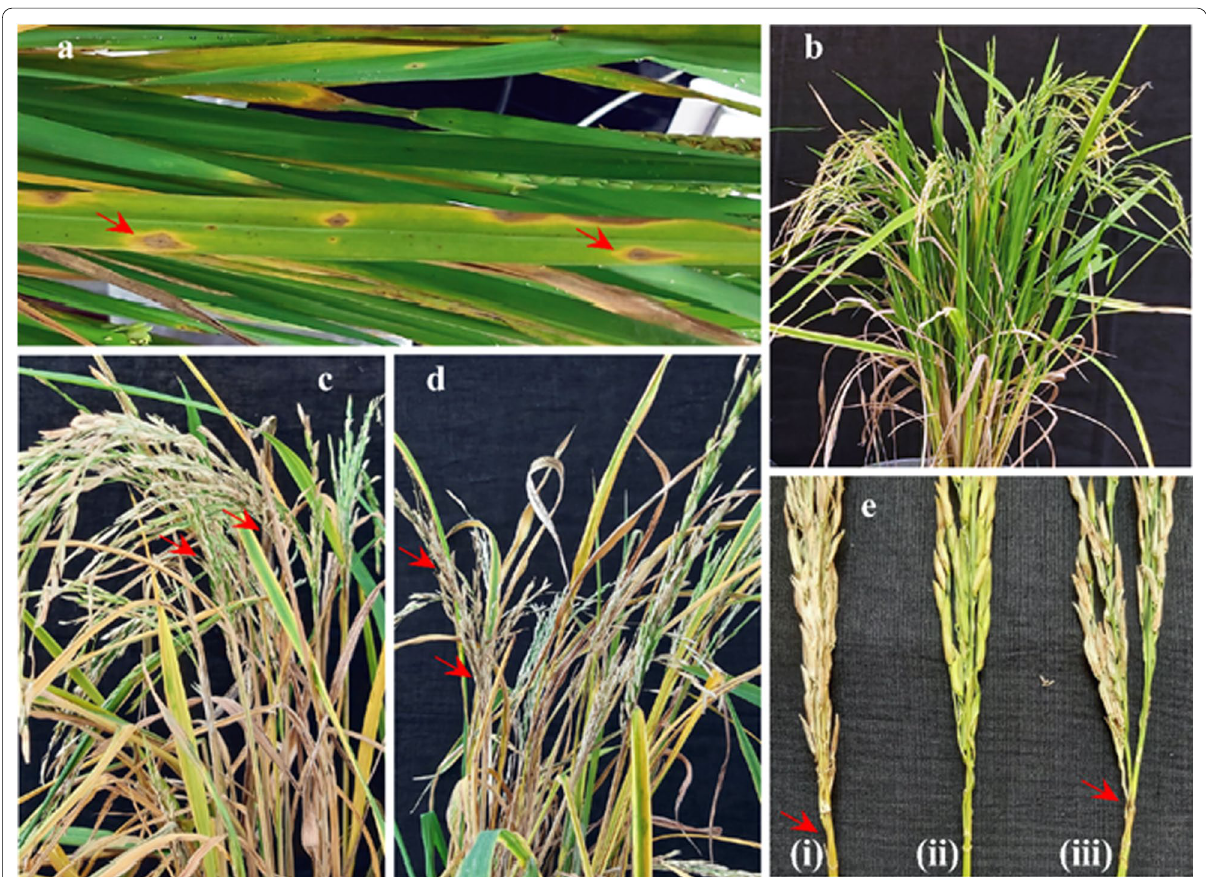
Fig. 2 Neck and leaf blast symptoms developed in rice cv. BRRI Dhan63 leaves and panicles after artificial inoculation of plants with conidia of MoO strains RB13b and RBTa1849‑2. a Typical eye‑shaped lesions with gray center (arrows) on the leaf of rice seedling. b Mock‑inoculated control plants showed no blast disease symptoms on leaves and panicles. c , d Partially bleached rice panicles by MoO strains RB13b ( c ) and RBTa1849‑2 ( d ). e Black‑pigmented infection appeared on panicle of rice plant inoculated with MoO strains, RB13b (i) and RBTa1849‑2 (iii), whereas middle panicle collected from mock‑inoculated control plant (ii) had no sign of infection